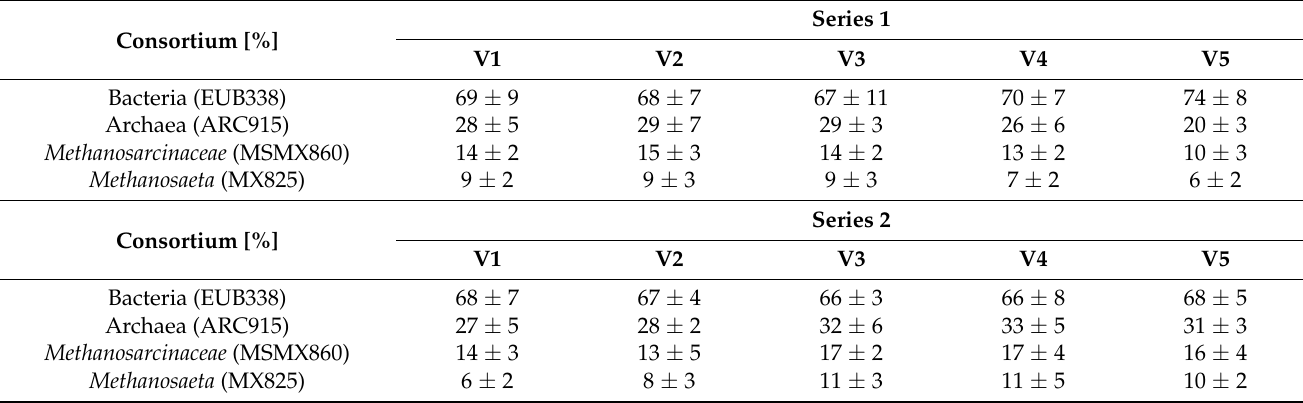
Table 3. Composition of the microbial community in the digesters across experimental